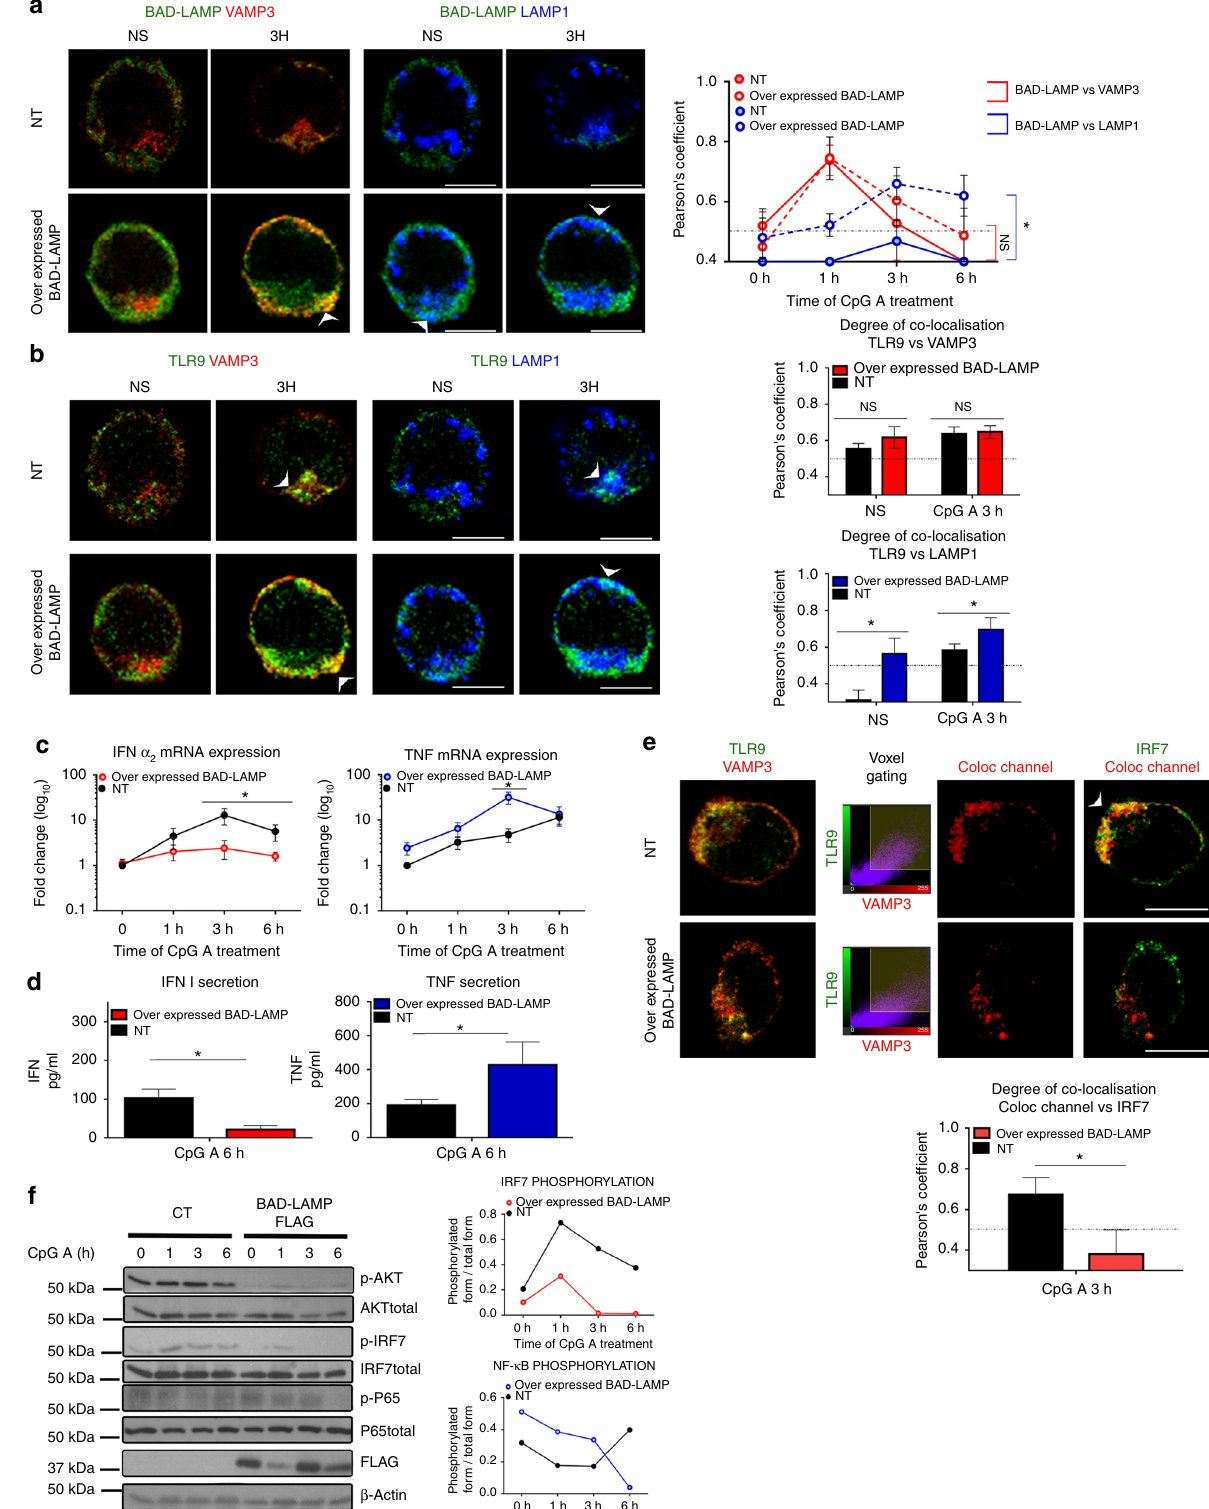
BAD-LAMP vs VAMP3 BAD-LAMP vs